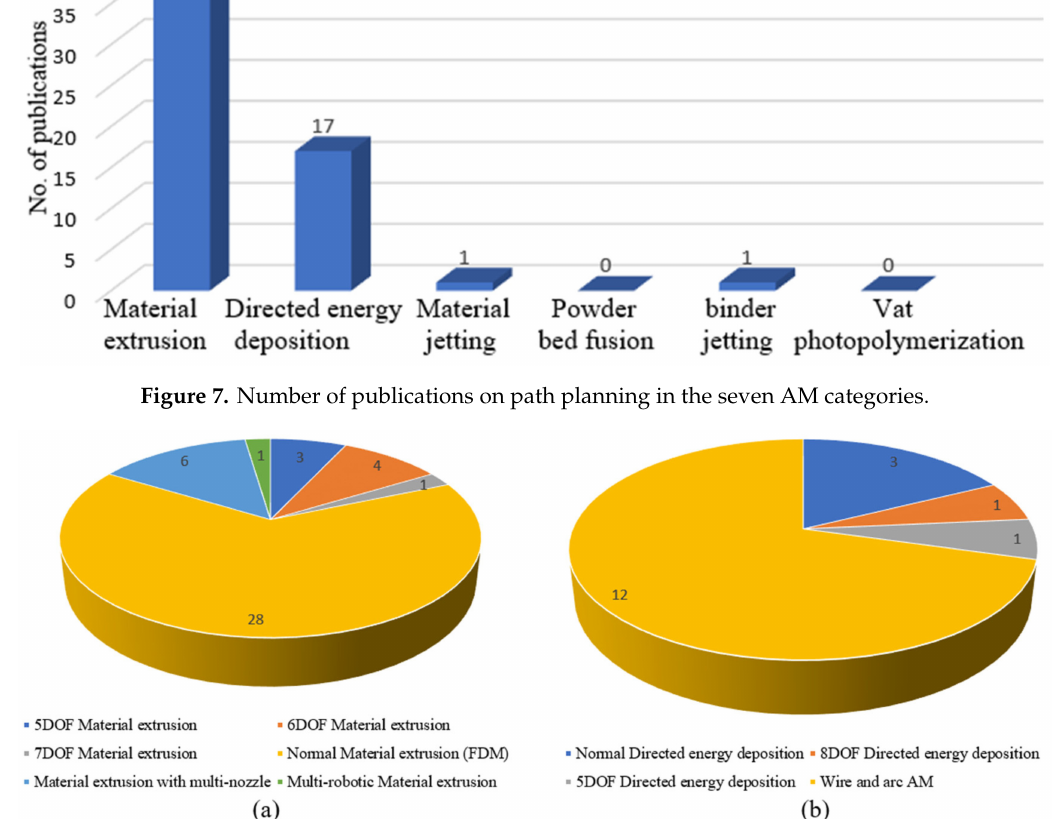
Figure 8. Distribution of published papers in material extrusion ( a ) and directed energy deposition ( b